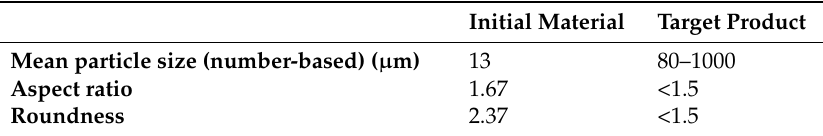
Table 1. Comparison of the initial material and the target